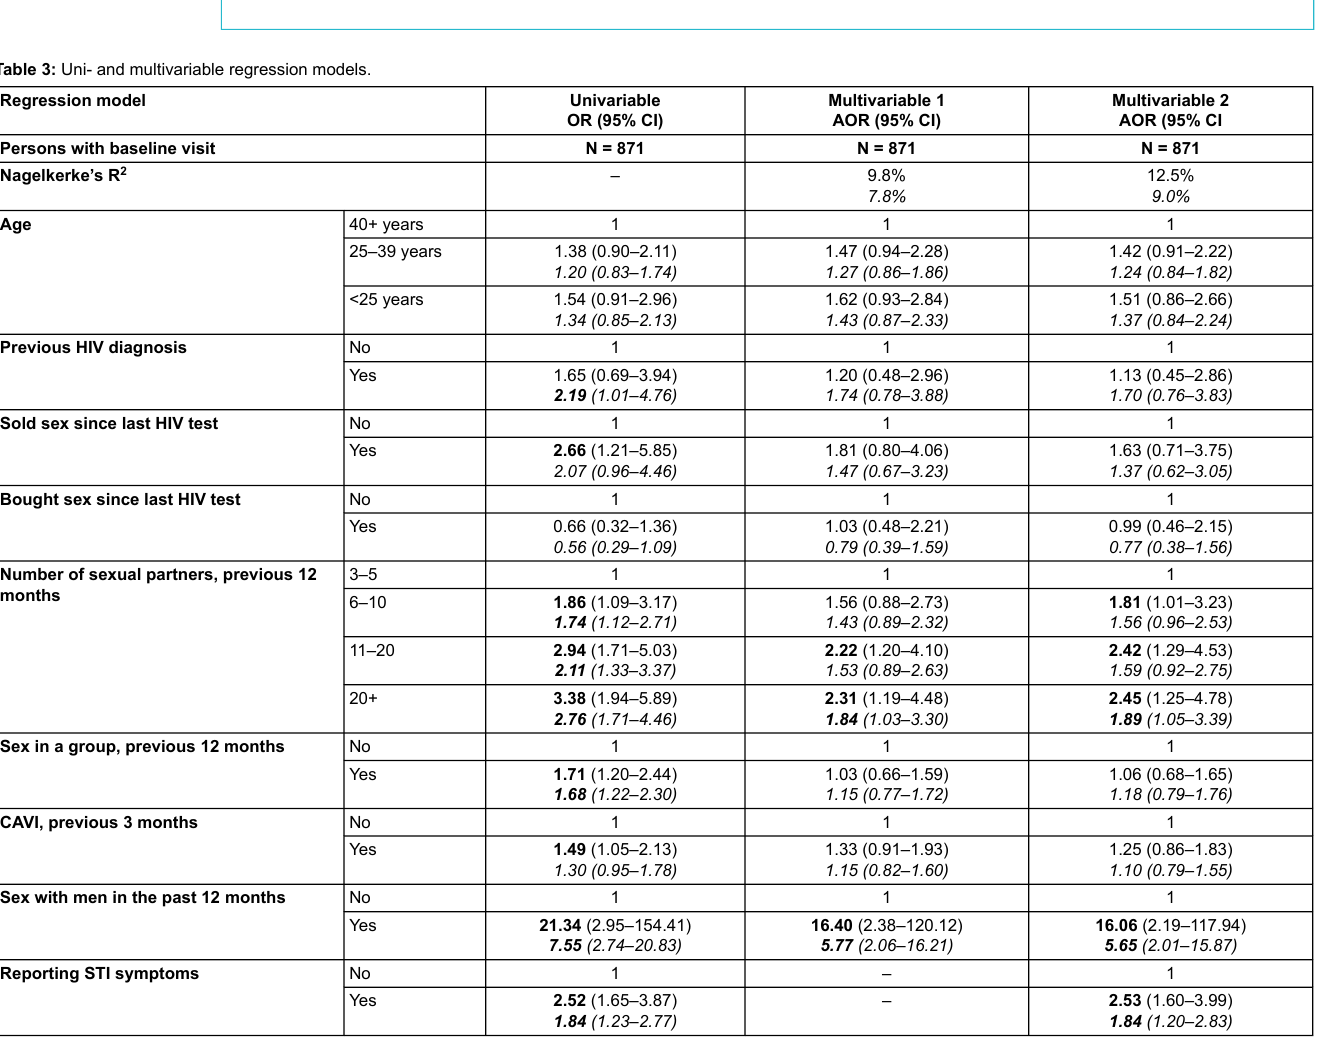
Table 3: Uni- and multivariable regression